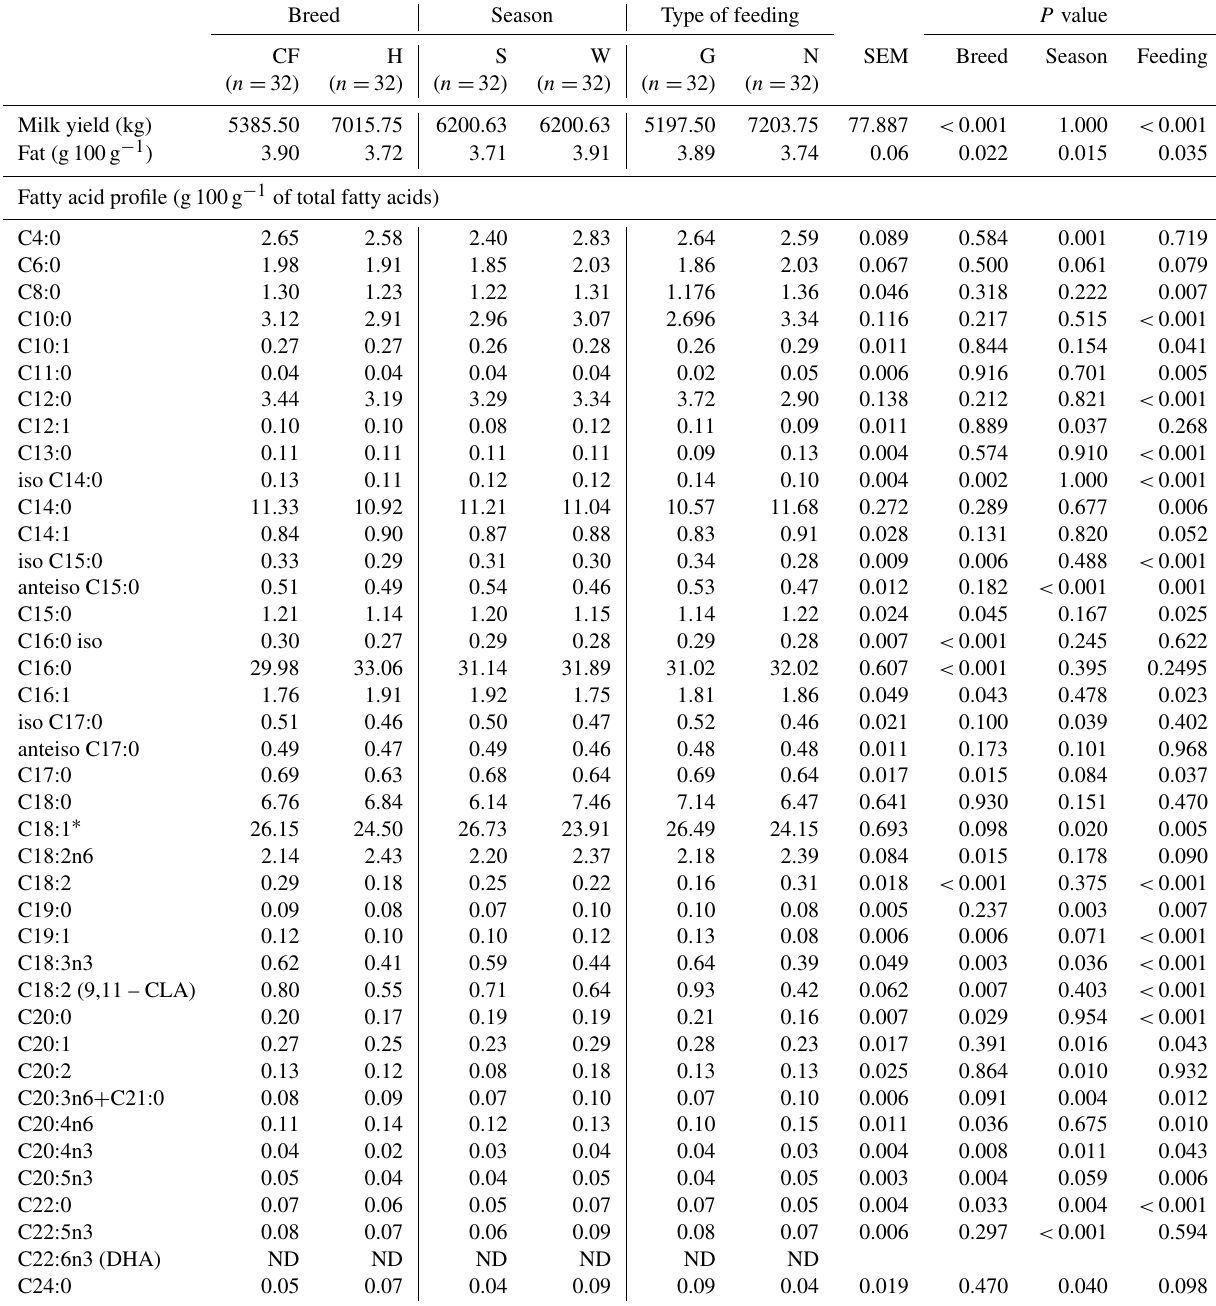
Table 3. Effect of cattle breed, season and type of feeding on the fatty acid profile (g100g − 1 of total fatty acids) of milk fat. Breed Season Type of feeding P value CF H S G SEM Breed Season